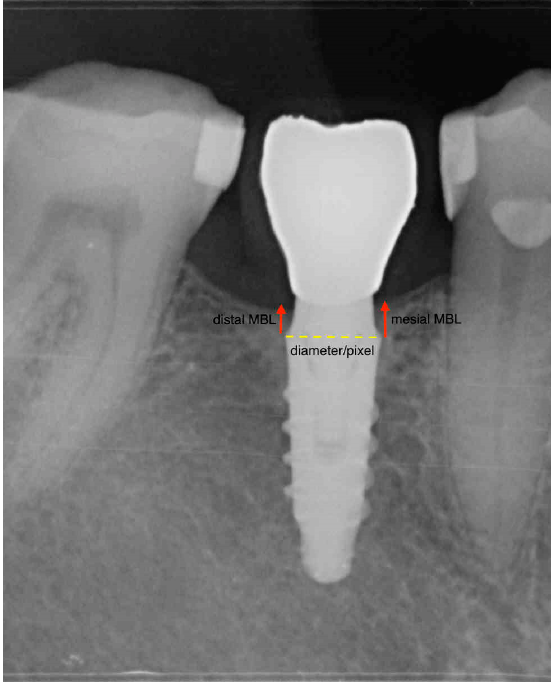
Figure 1. The picture is a schematic representation of the calibration performed on the software to achieve bone level linear measurements. The scale was set and calibrated by the width of the dental implant.